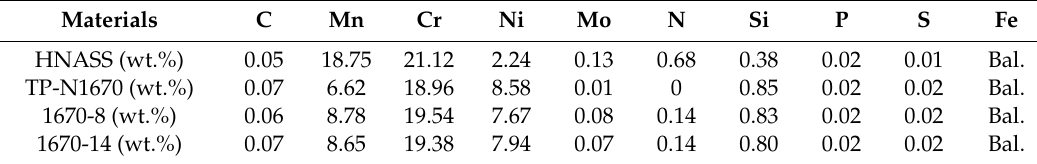
Figure 1. Schematic of welding wire.